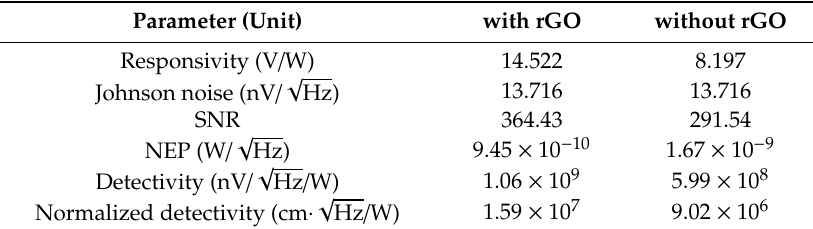
Table 1. Figure of merits of the thermopiles.